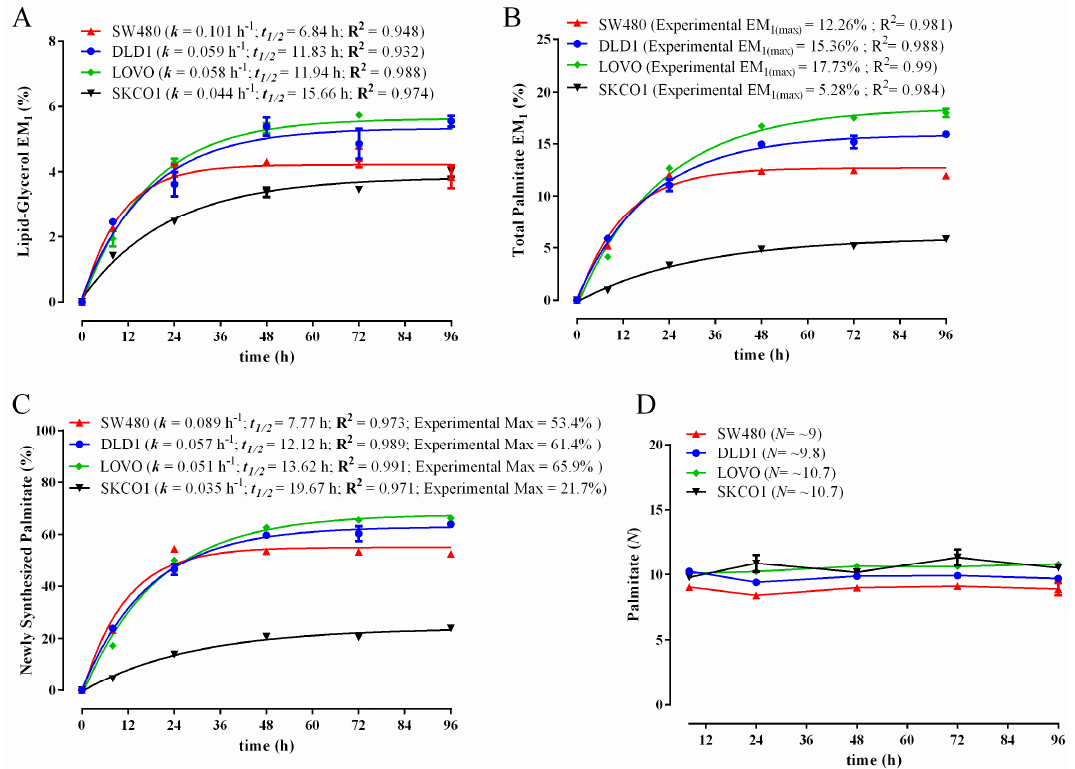
Figure 6. Comparison of 2 H-incorporation into lipid-derived glycerol and total palmitate in colon cancer cell lines following incubation in 5% 2 H 2 O for 96 h. Excess molar enrichment in the M 1 isotopomer (EM 1 ) over time in lipid-derived glycerol ( A ) and total intracellular palmitate ( B ) in human colon cancer cell lines grown under identical conditions. Percentage of newly-synthesized palmitate in colon cancer cell lines ( C ). The experimental maximum (plateau) value represents the percentage of the total intracellular palmitate pool that was de novo derived. The maximum number of exchangeable carbon bound hydrogens ( N ) in palmitate as determined using MIDA ( D ). Inset: fractional synthesis rate constant ( k ), half-life ( t 1/2 ) and goodness-of-fit (R 2 ) from non-linear curve fitting. N values seen in the brackets of the legend (D) are an average of those obtained at the 48-, 72- and 96-h time points; these exhibited the greatest amount of labelling and, therefore, permit the most accurate calculation of N using MIDA. Three replicates were performed for each time point. Error bars represent the standard error of the mean (SEM).